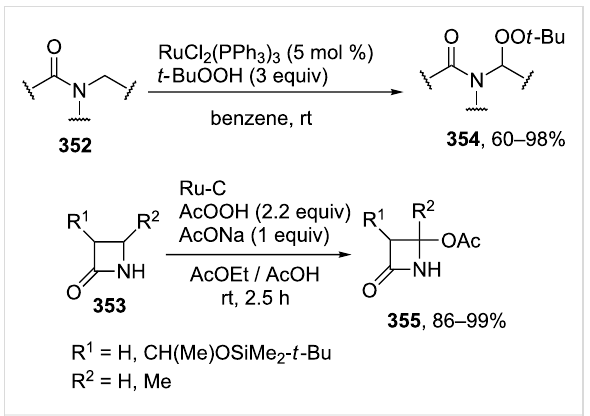
Scheme 80: Ruthenium-catalyzed tert -butyl peroxydation amides and acetoxylation of β -lactams.